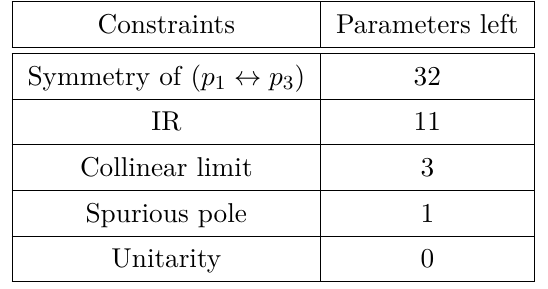
Figure 12. A simple quadruple cut to determine the coefficient of I (1)